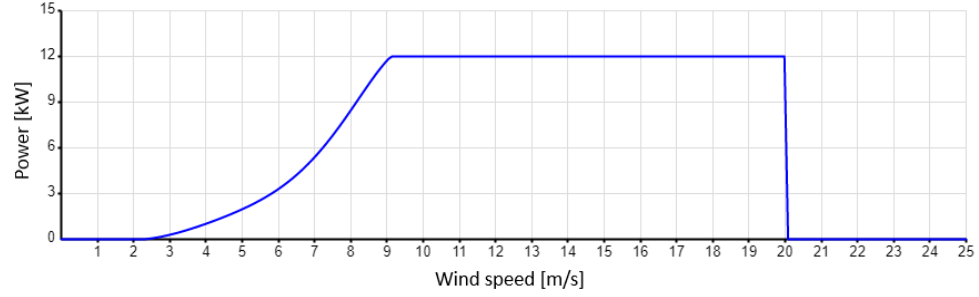
Figure 4. Power curve of the tested turbine